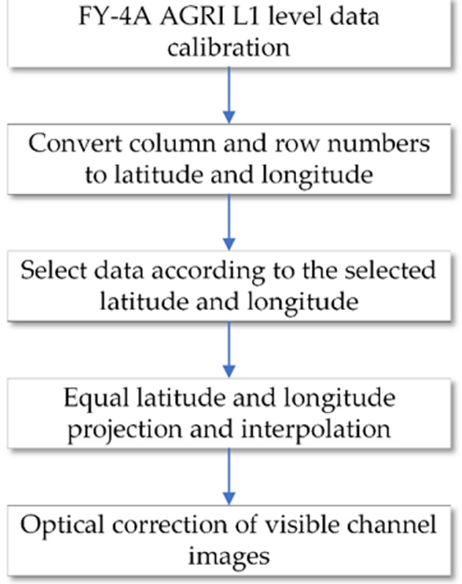
Figure 6. Data preprocessing